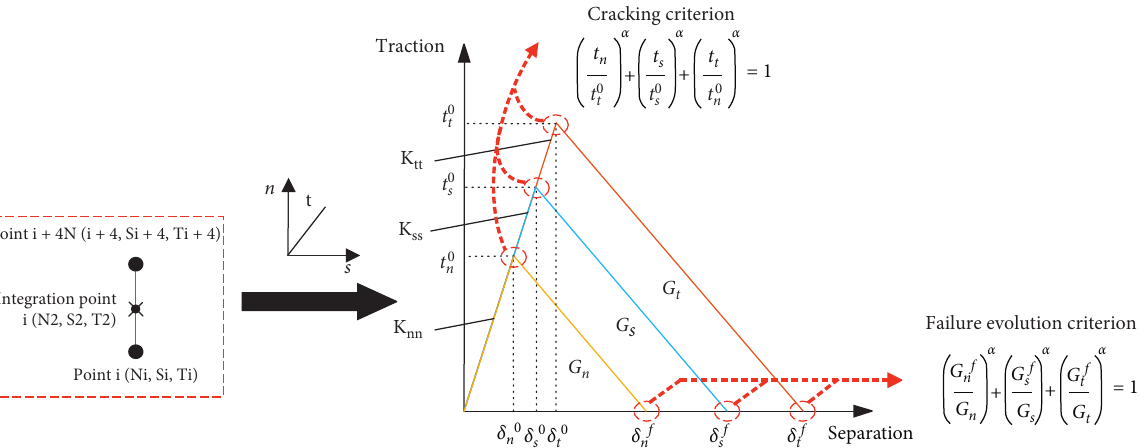
Figure 12: Constitutive model of the cohesive interface